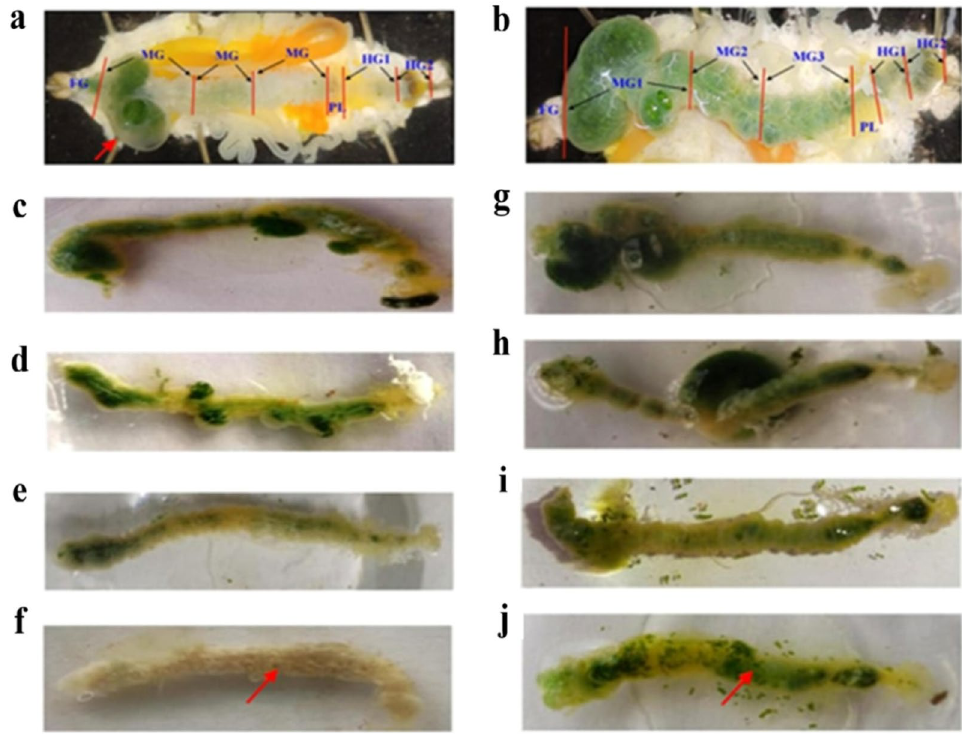
Figure 3. Anatomical comparison between infected and non-infected B. mori larvae. ( a ) Red arrow showing gut content accumulation in the infected larvae. ( b ) Control larvae showed green gut content throughout the alimentary canal (FG, MG1, MG2, MG3, PL, HG1, and HG2). ( c – f ) The green color of gut content in the alimentary canal decreased gradually and appeared complete white in fourth day of infected larvae. ( g – j ) Control larvae showed no changes in gut